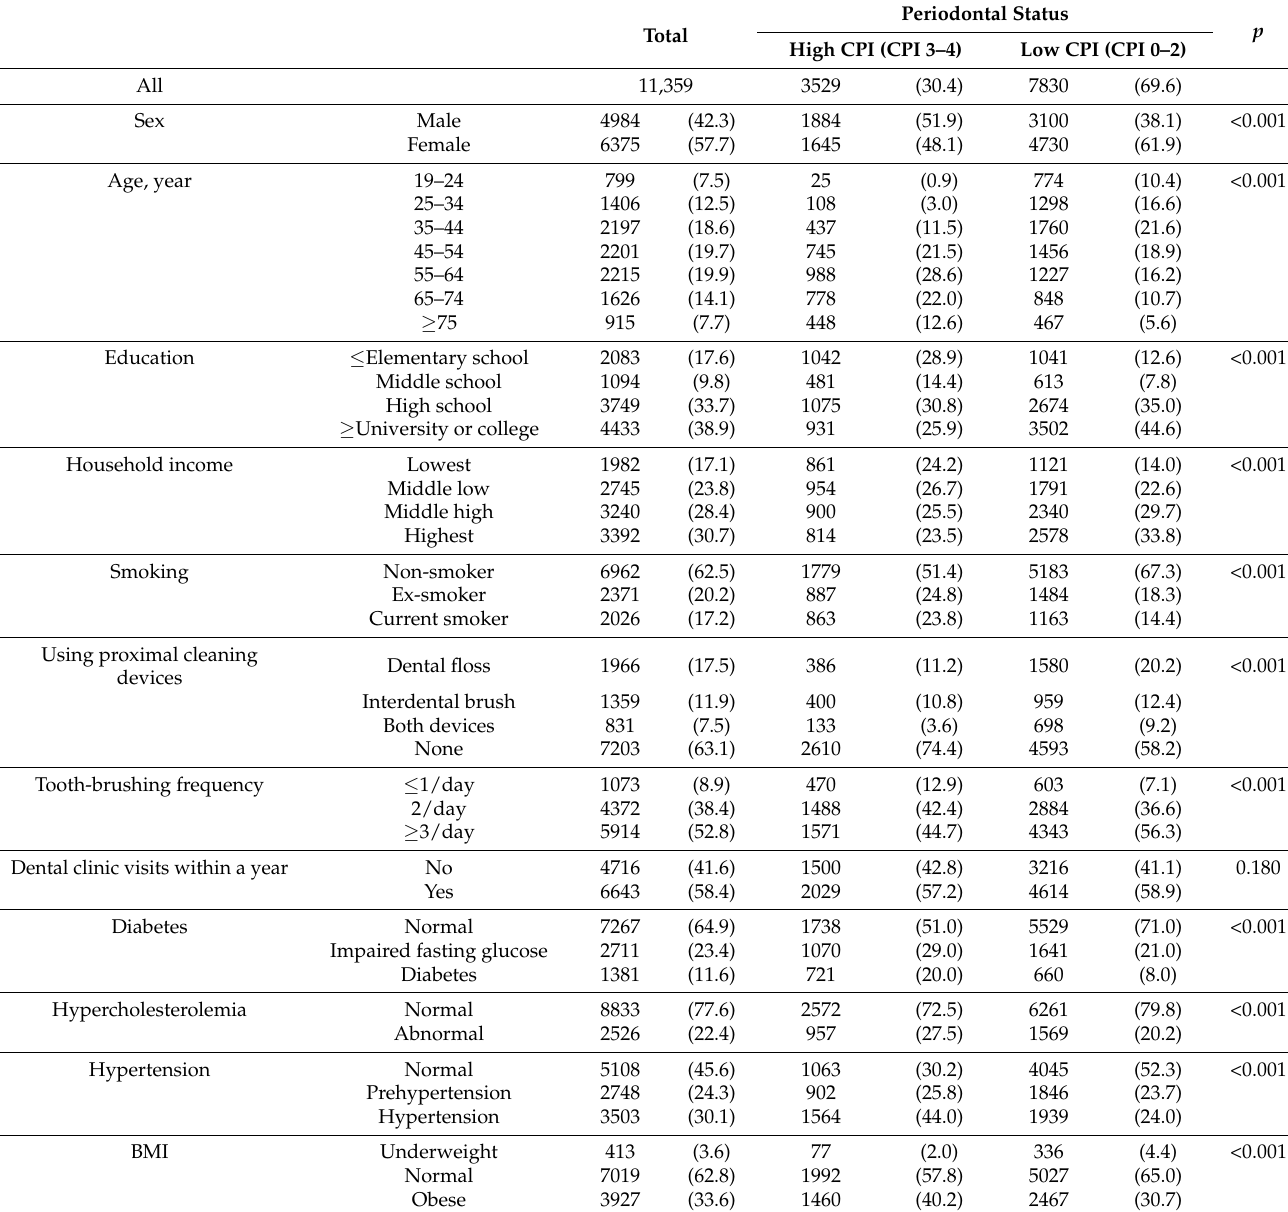
Table 1. Characteristics of the study population with periodontal